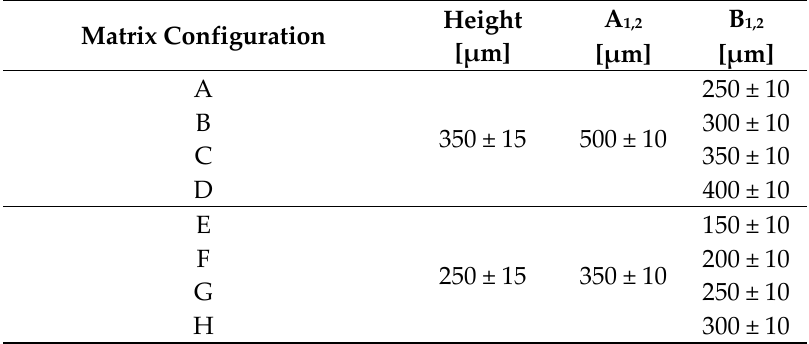
Table 1. Various geometrical configurations of the glass microprisms